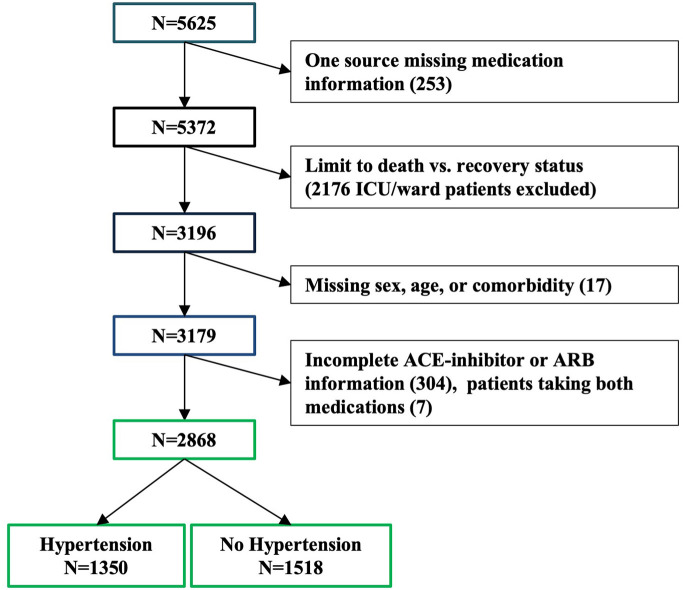
Flow chart of patient sample sizes.